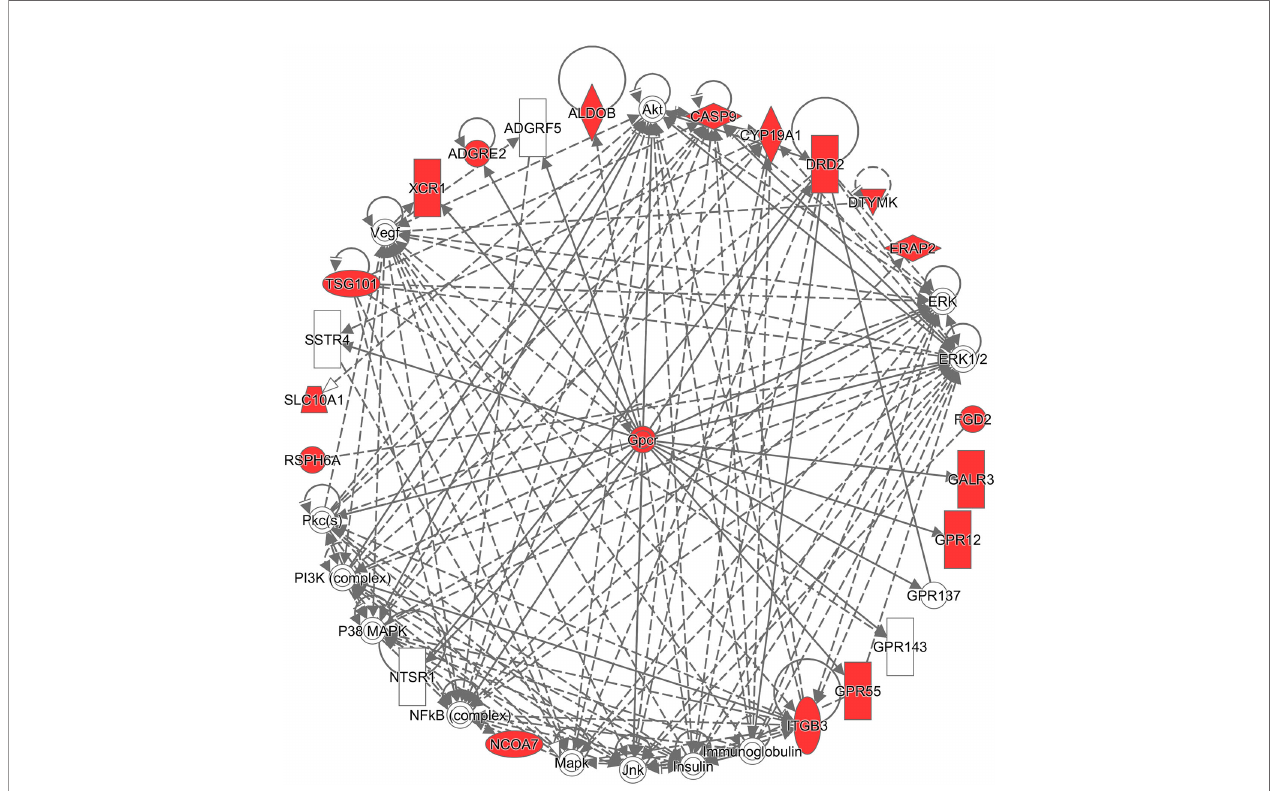
FIGURE 3 | Network analysis using the Ingenuity ® Pathway Analysis (IPA ® ) software program. The red colored the genes which are in the list of our differentially expressed genes, and white colored the putative genes based on IPA